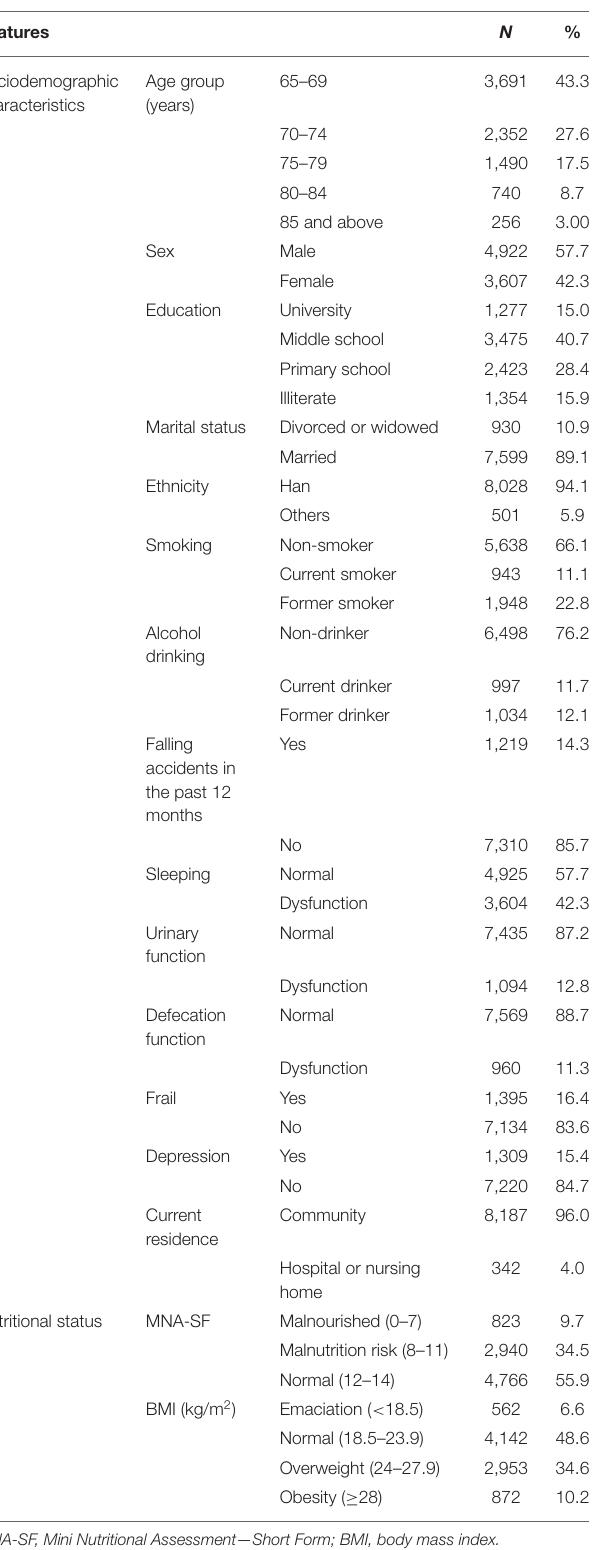
MNA-SF, Mini Nutritional Assessment—Short Form; BMI, body mass